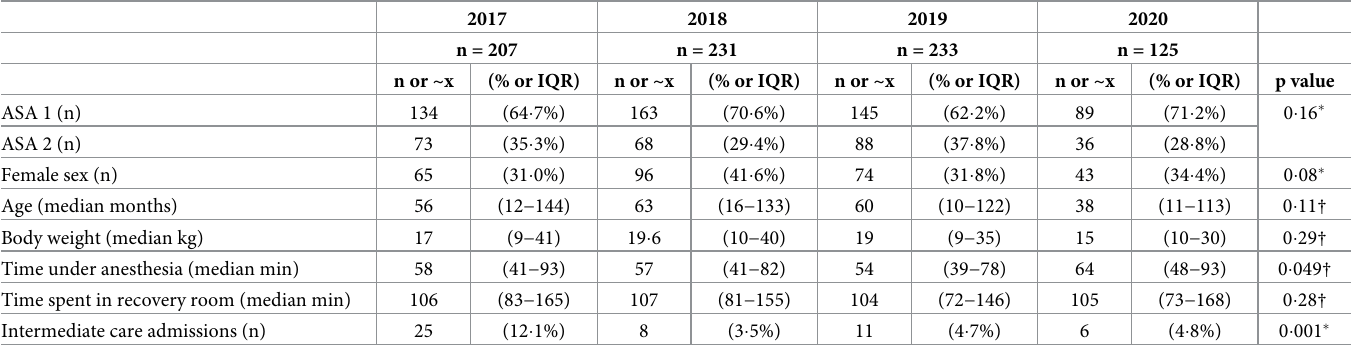
Table 1. Pertinent basic